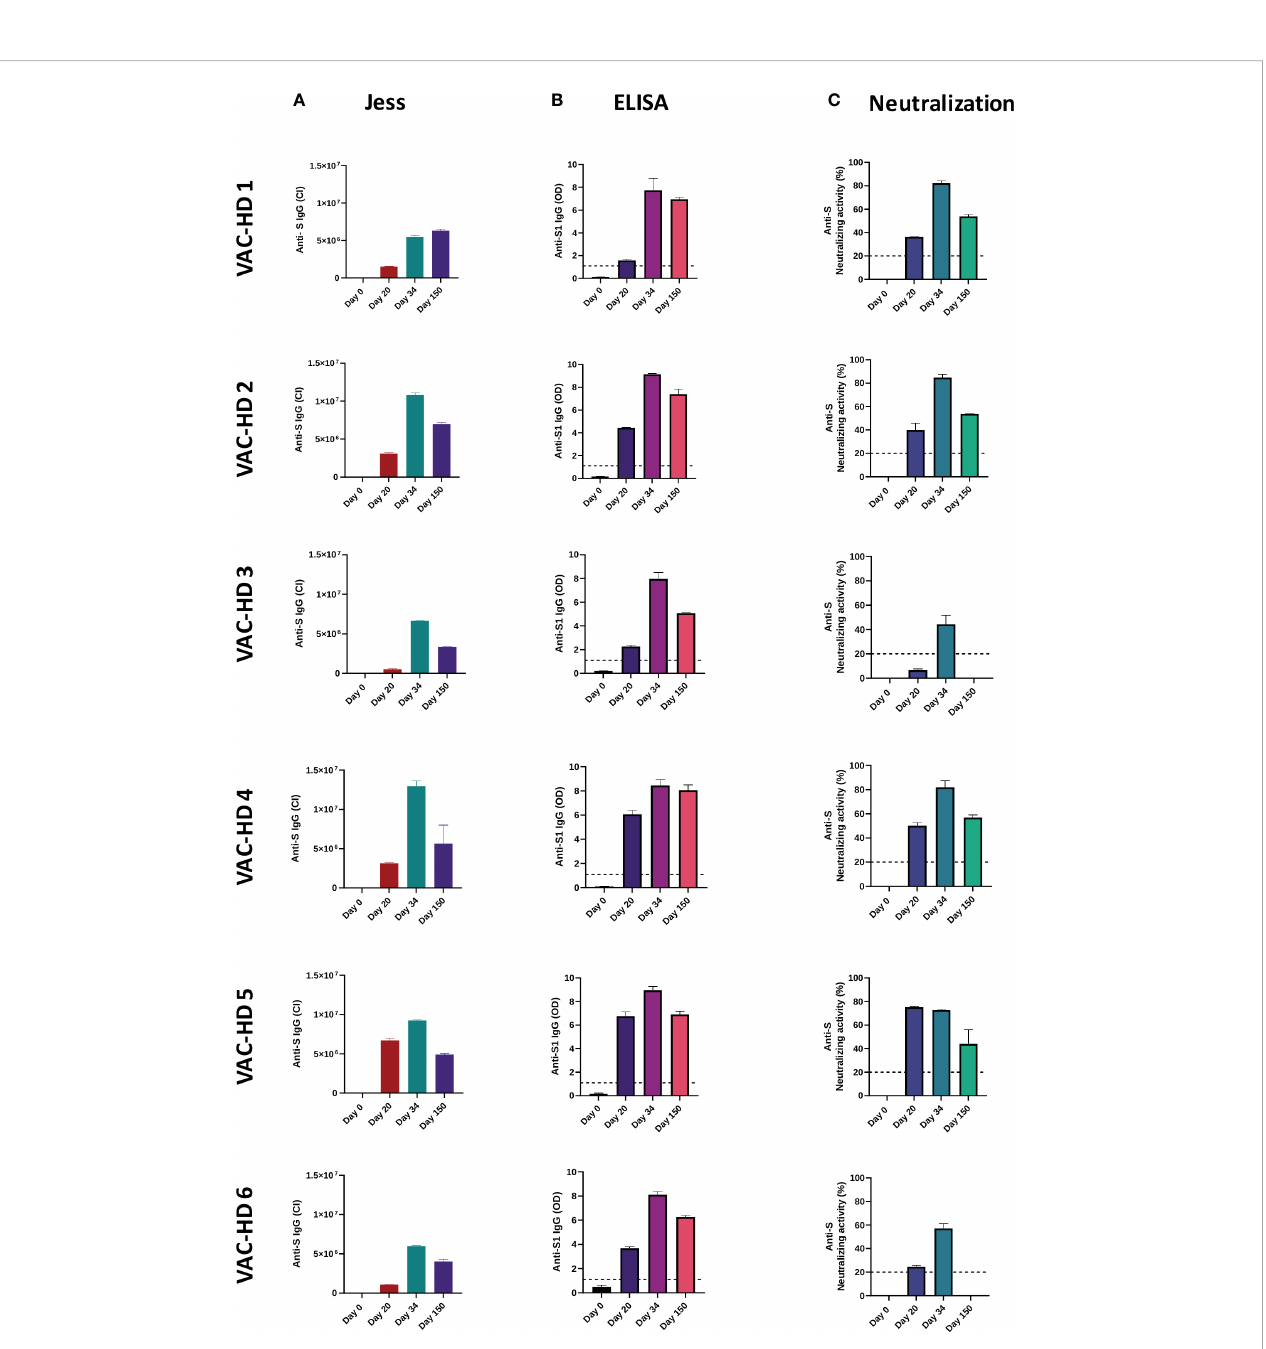
FIGURE 1 Interpersonal variation of anti-spike binding and neutralizing antibodies responses over time among BNT162b2 vaccinated participants. Serum samples were collected from six BNT162b2 vaccinated participants at the baseline, 20-, 34-, and 150-days post-vaccination. The anti-S and anti-S1 IgG levels were assessed using Jess and ELISA, respectively. The anti-S neutralizing activity was measured using the neutralization assay. (A) Anti-S IgG response in six BNT162b2 vaccinated participant over time (Jess). (B) Anti-S1 IgG response in six BNT162b2 vaccinated participant over time (ELISA). (C) Anti-S neutralizing activity in each BNT162b2 vaccinated participant over time (Neutralization assay). The lines indicate the cut-off value of a positive antibody